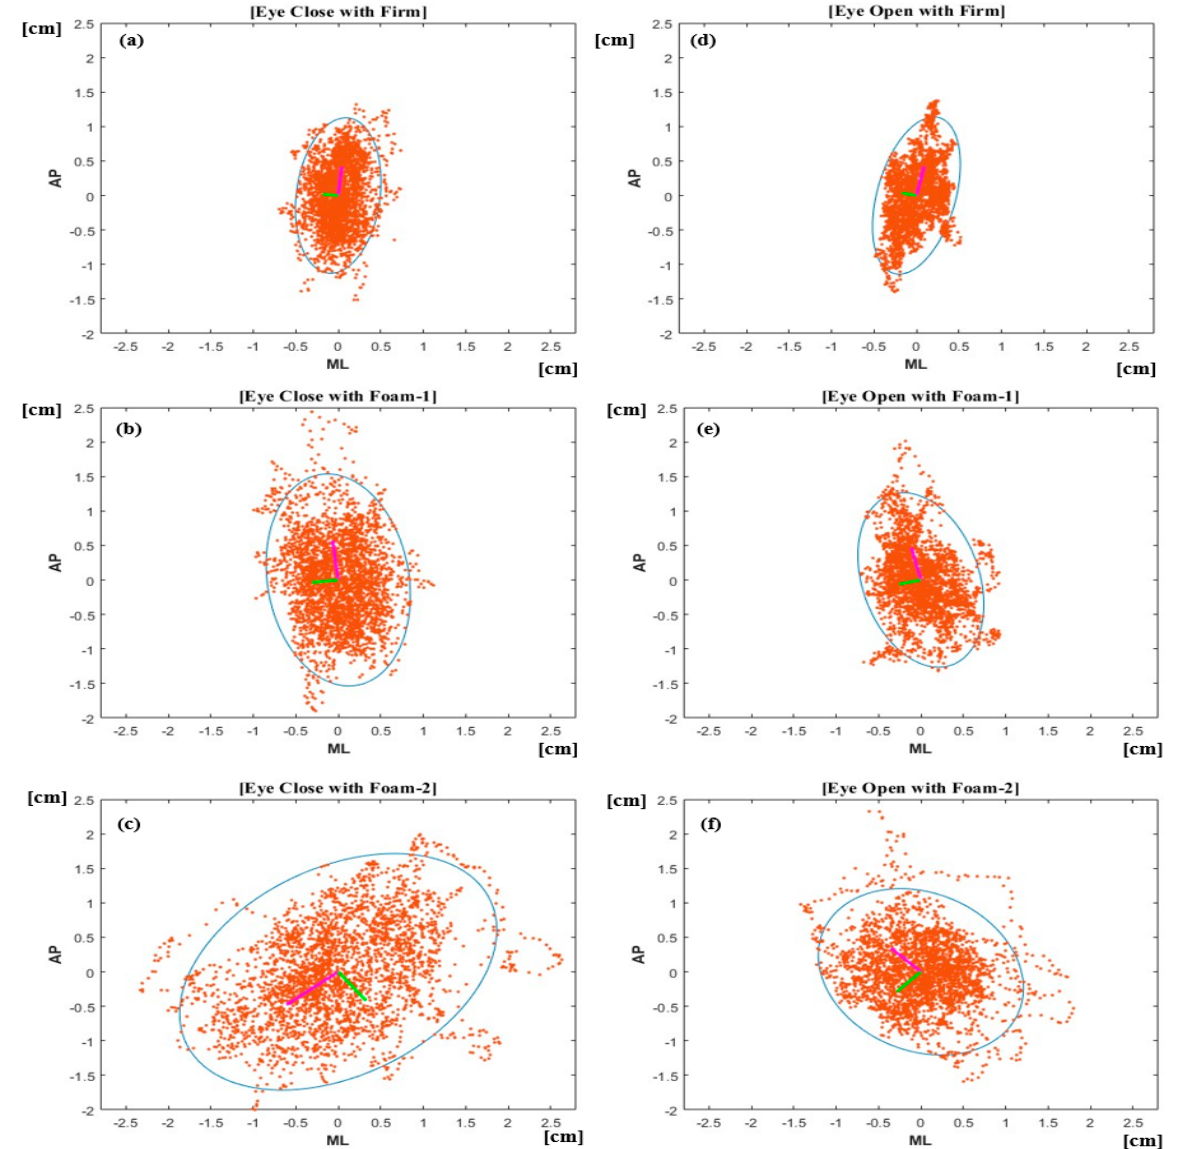
Figure 3. CoP for ( a ) eyes closed on firm ground, ( b ) eyes closed on Foam-1, ( c ) eyes closed on Foam-2, ( d ) eyes open on firm ground, ( e ) eyes open on Foam-1, and ( f ) eyes open on Foam-2. Blue circle: 95% covariance of eigenvalue area, Pink arrow: largest eigen vector, Green arrow: smallest eigen vector.